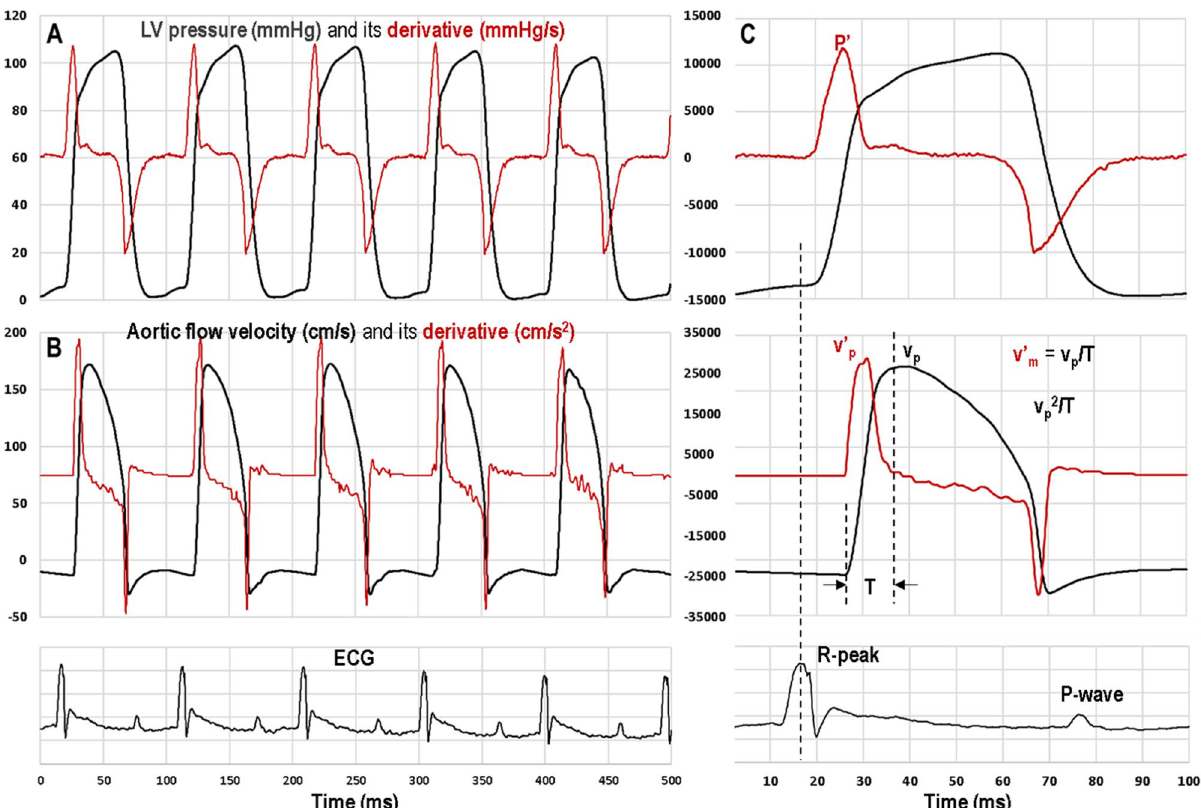
Figure 2. Waveforms of ( A ) invasively measured left ventricular pressure (P) waveform and its first derivative (P ′ ) and ( B ) noninvasively measured aortic outflow velocity (v) waveform and its first derivative (v ′ ). ( C ) Figure showing the invasive parameter left ventricular P ′ and the noninvasive parameters peak aortic velocity (v p ), peak aortic velocity squared/rise time (v